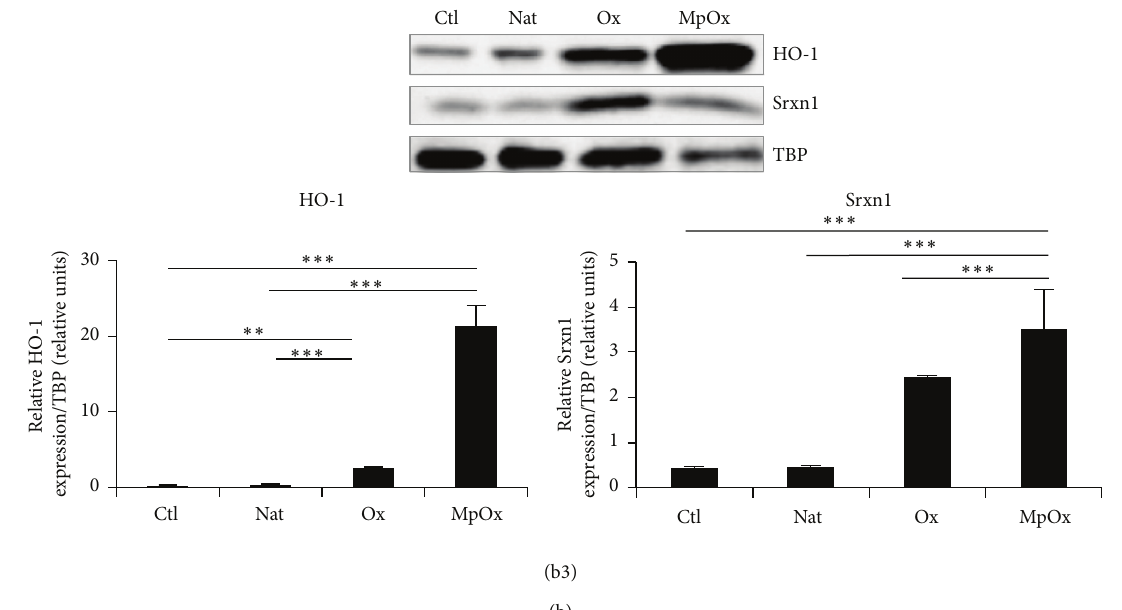
Figure 3: Comparative effects of LDLs on marker gene expression in unpolarized RAW 264.7 M0 macrophages. M0 macrophages were treated for 24 hours in the presence of medium alone (Ctl), native LDLs (Nat), Ox-LDLs (Ox), or MpOx-LDLs (MpOx) (100 𝜇 g/mL). (a) Expression of polarization marker genes at the mRNA level (RT-qPCR). The expression of marker genes was analyzed by RT-qPCR as in Figure 1. Data are normalized with TBP used as housekeeping gene and expressed as mean fold induction relatively to Ctl cells ± SD ( 𝑛 = 3 ). (b) Expression of polarization markers at the protein level (FACS, ELISA, and WB) in Ctl and Nat-LDLs-, Ox-LDLs-, and MpOx-LDLs- treated M0 macrophages. (b1). Production of secreted IL-6 (M1 marker) in cell culture supernatants assessed by ELISA. Data are expressed relatively per 𝜇 g of protein per well as mean ± SD ( 𝑛 = 3 ). (b2) Surface expression of MRC1 (M2 marker) analyzed by flow cytometry in Ctl , 0; Δ GMF Ox , 20.75; and Δ GMF MpOx , 33.82. and treated macrophages (m 𝜑 ). GMF values are reported in arbitrary units: Δ GMF Nat - CTL - CTL - CTL The data presented are representative of 3 independent experiments. (b3) Expression of HO-1 and Srxn1 assessed by Western blotting in Ctl and Nat-LDLs-, Ox-LDLs-, and MpOx-LDLs-treated macrophages. Data are normalized with TBP used as loading control and expressed as mean ± SD ( 𝑛 = 3 ). Results are representative of 3 independent experiments. ANOVA 1: ∗ 𝑝 < 0.05 ; ∗∗ 𝑝 < 0.01 ; and ∗∗∗ 𝑝 < 0.001